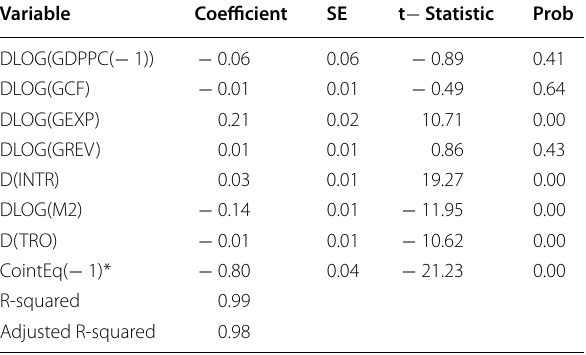
Table 6 Short-run parameters and the speed of adjustment Variable